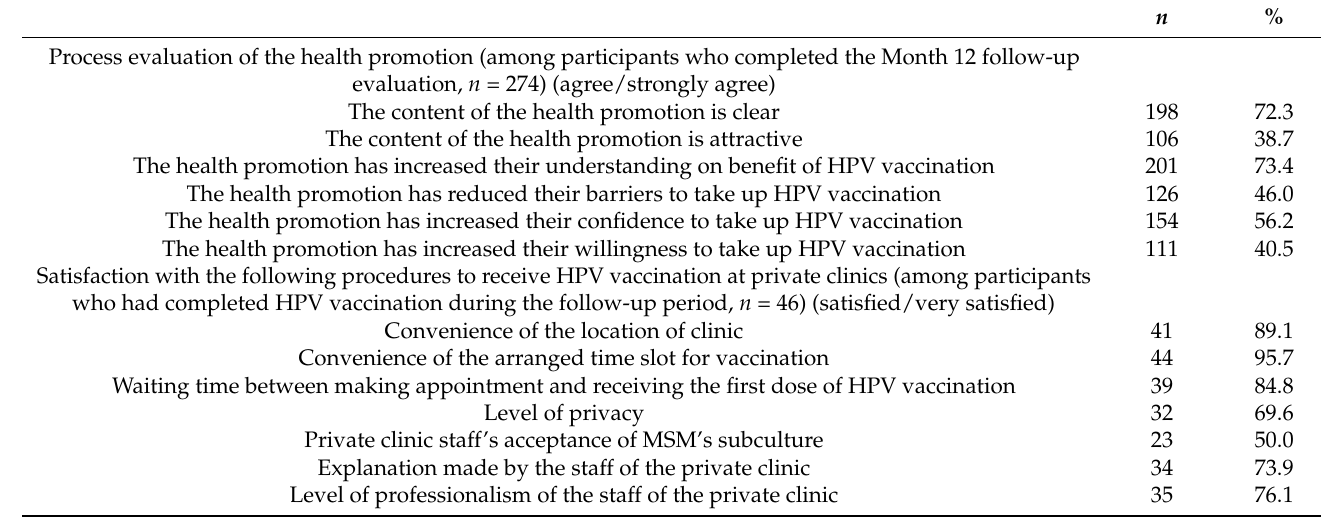
Table 4. Process evaluation of the health promotion and the procedures to receive human papillomavirus vaccination at private